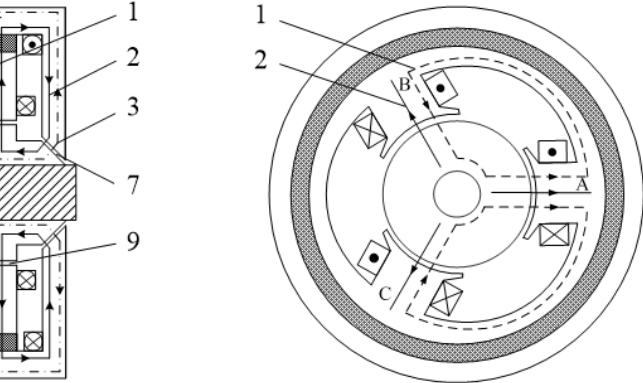
Figure 1. A 3D model of the 5-DOF AC–DC HMB.